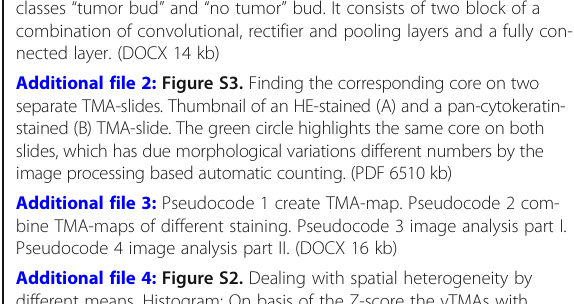
image processing based automatic counting. (PDF 6510